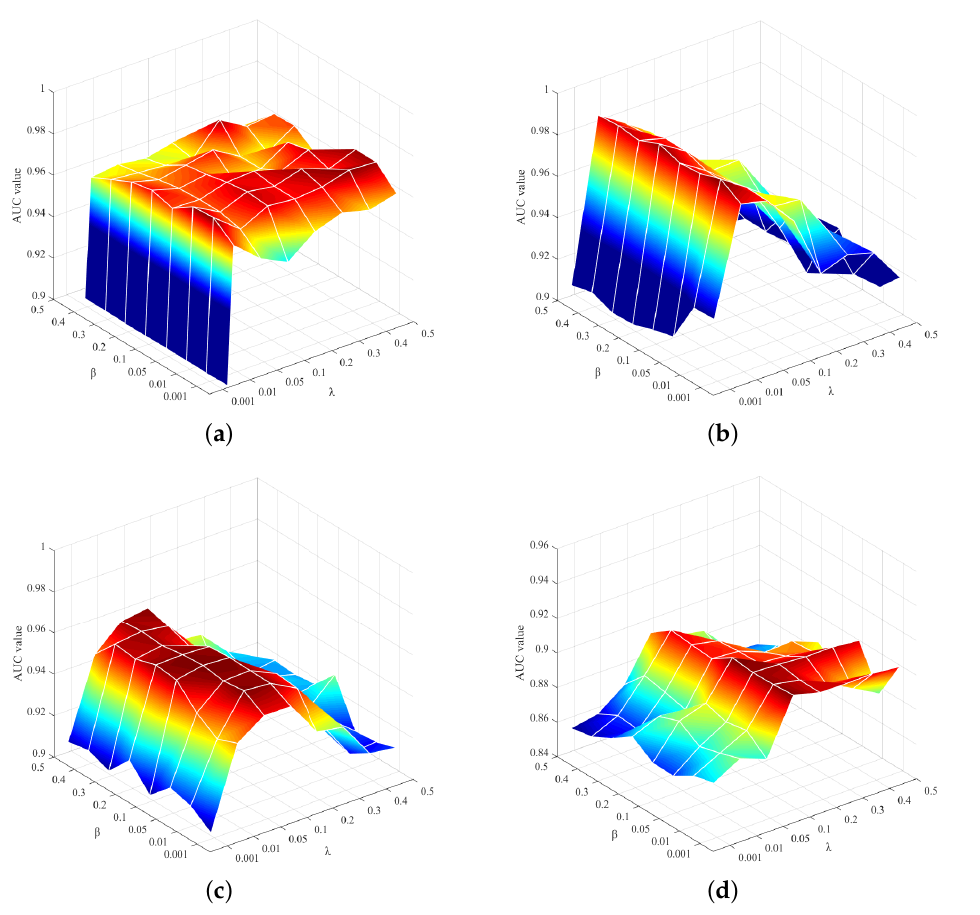
Figure 13. Analysis of the tradeoff parameters β and λ on four different datasets. ( a ) Simulated dataset; ( b ) AVIRIS–I dataset; ( c ) AVIRIS–II dataset; ( d ) HYDICE